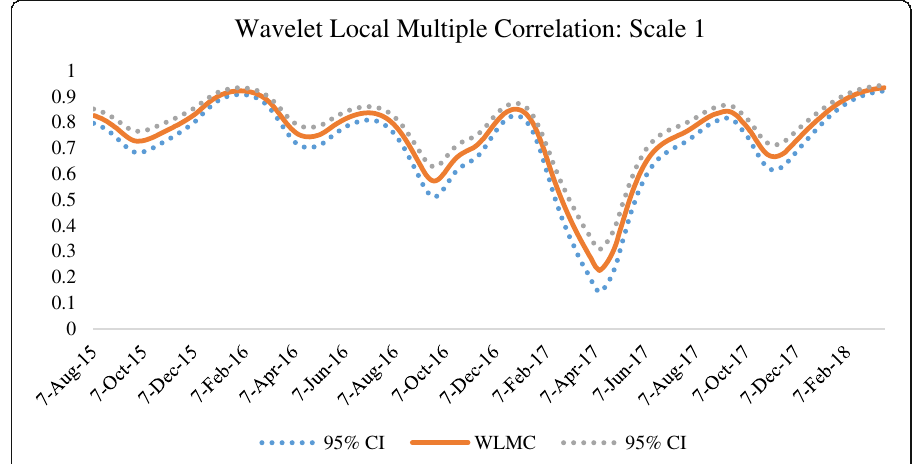
Fig. 4 Wavelet Local Multiple Correlation for scale 1 (2 – 4-day time